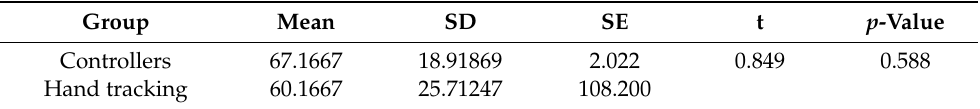
Table 5. Independent sample t -test results of SUS scores. Group